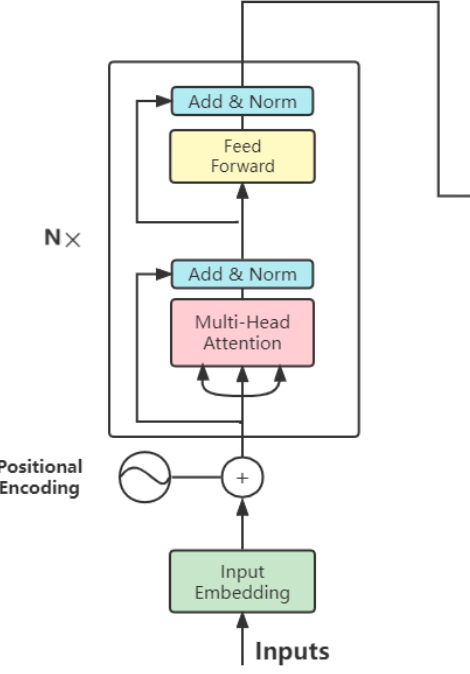
Figure 5. The structure of Transformer encoder (Redrawn from